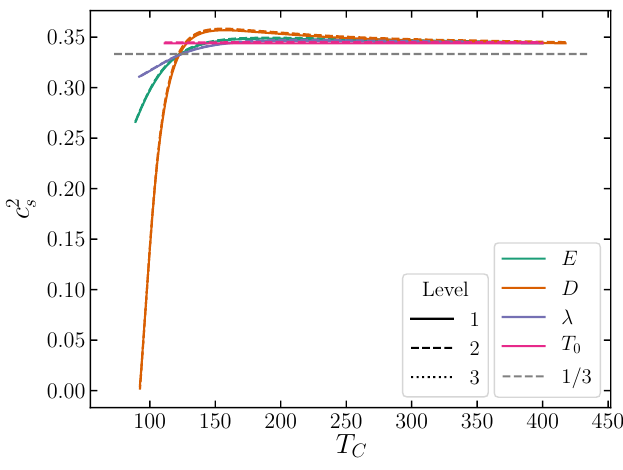
Figure 14 . Speed of sound computed in the different levels of